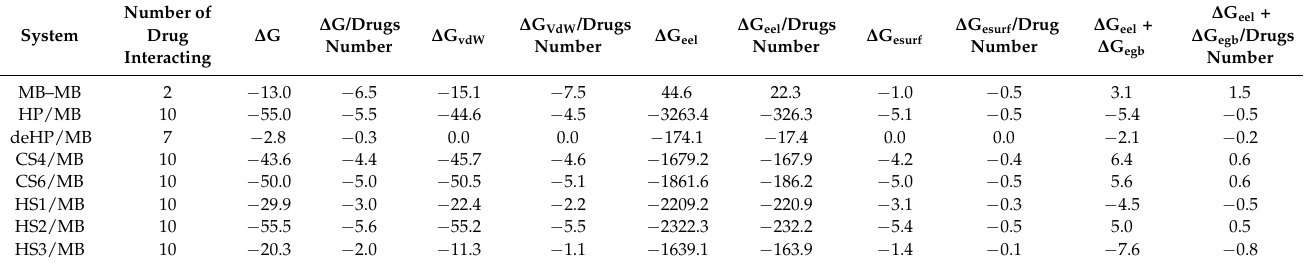
Table 1. MM–GBSA binding free energy analysis of MB–GAG dp10